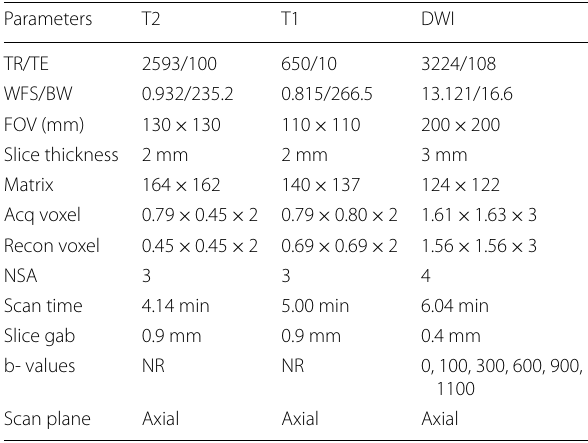
DWI diffusion-weighted imaging, TE = WFS water fat shift, BW = averages, NR not relevant. Acq =